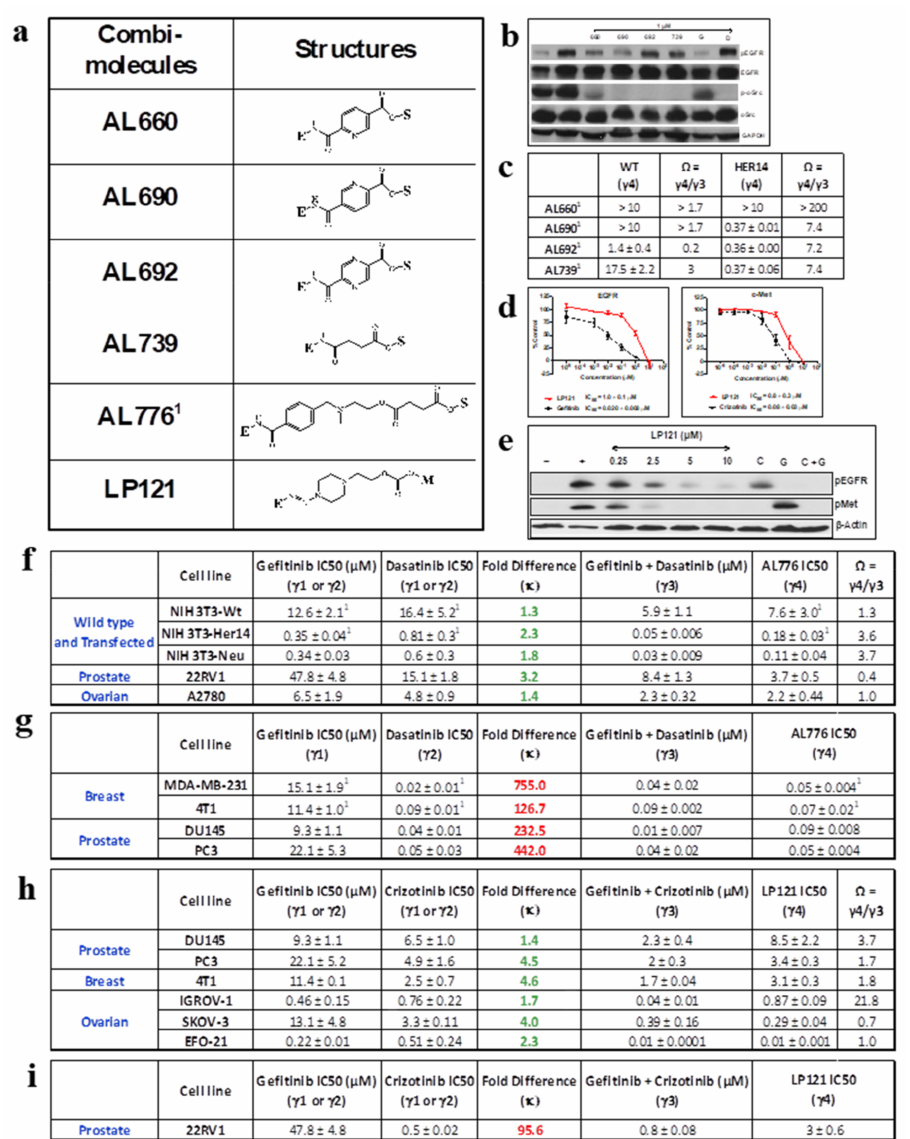
Figure 5. ( a ) Structures of EGFR-c-Src (AL660-AL776) and EGFR-c-Met (LP121) combi-molecules. E = EGFR targeting head, S = c-Src targeting head, and M = c-Met targeting head (structures shown in Figure S1 and Schemes S1–S4 in the supplementary section). ( b ) Immunoblot analysis of inhibition of EGFR and c-Src phosphorylation by 1 µ M dose of EGFR-c-Src-targeting combi-molecules (i.e., AL660, AL690, AL692, AL739) and the clinical inhibitors gefitinib (G) and dasatinib (D) in NIH3T3-Her14 (EGFR transfected) cells stimulated with 50 ng/mL of EGF. ( c ) IC50 values of growth inhibition and the combi-targeting effect, Ω ( γ 4/ γ 3) for imbalanced targeting combi-molecule on the NIH3T3-wild type and Her14 (EGFR transfected) cells. ( d ) EGFR and c-Met kinase inhibitory potency of LP121 using an in vitro kinase assay. ( e ) Target modulation by LP121, C—crizotinib (5 µ M), G—gefitinib (5 µ M), and C + G—an equimolar combination of crizotinib + gefitinib (5 µ M each) in 4T1 cells using western blot analysis under conditions of EGF + HGF (50 ng/mL each) stimulation. ( f , g ) IC50 values of growth inhibition of the balance-targeted combi-molecule AL776 and the equivalent equimolar drug combination. Ω ( γ 4/ γ 3) was calculated for cell lines with κ ≤ 6. ( h , i ) IC50 values of growth inhibition of the balanced-targeted combi-molecule LP121 and the equivalent equimolar drug combination. Ω ( γ 4/ γ 3) was calculated for cell lines with κ ≤ 6. 1 Rao et al. 2015